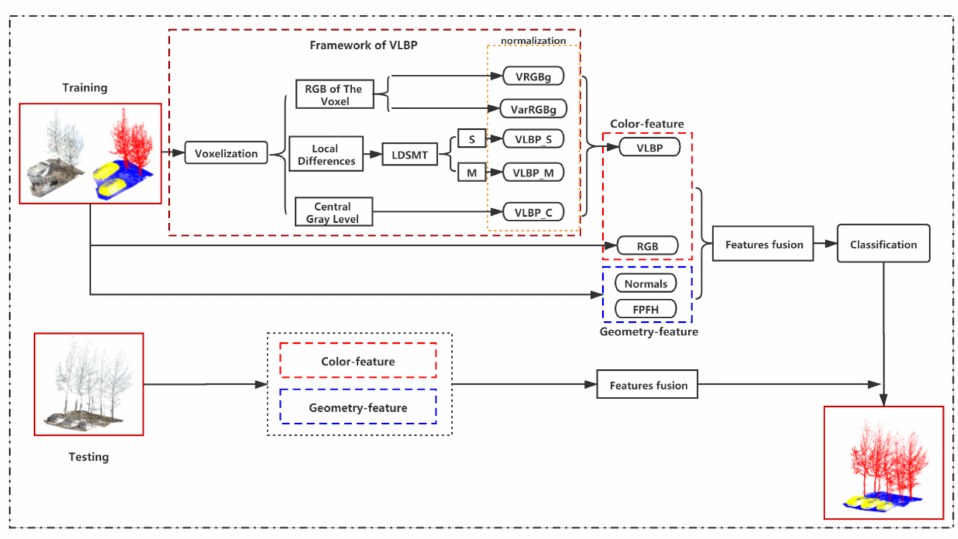
Figure 1. The flowchart of the proposed